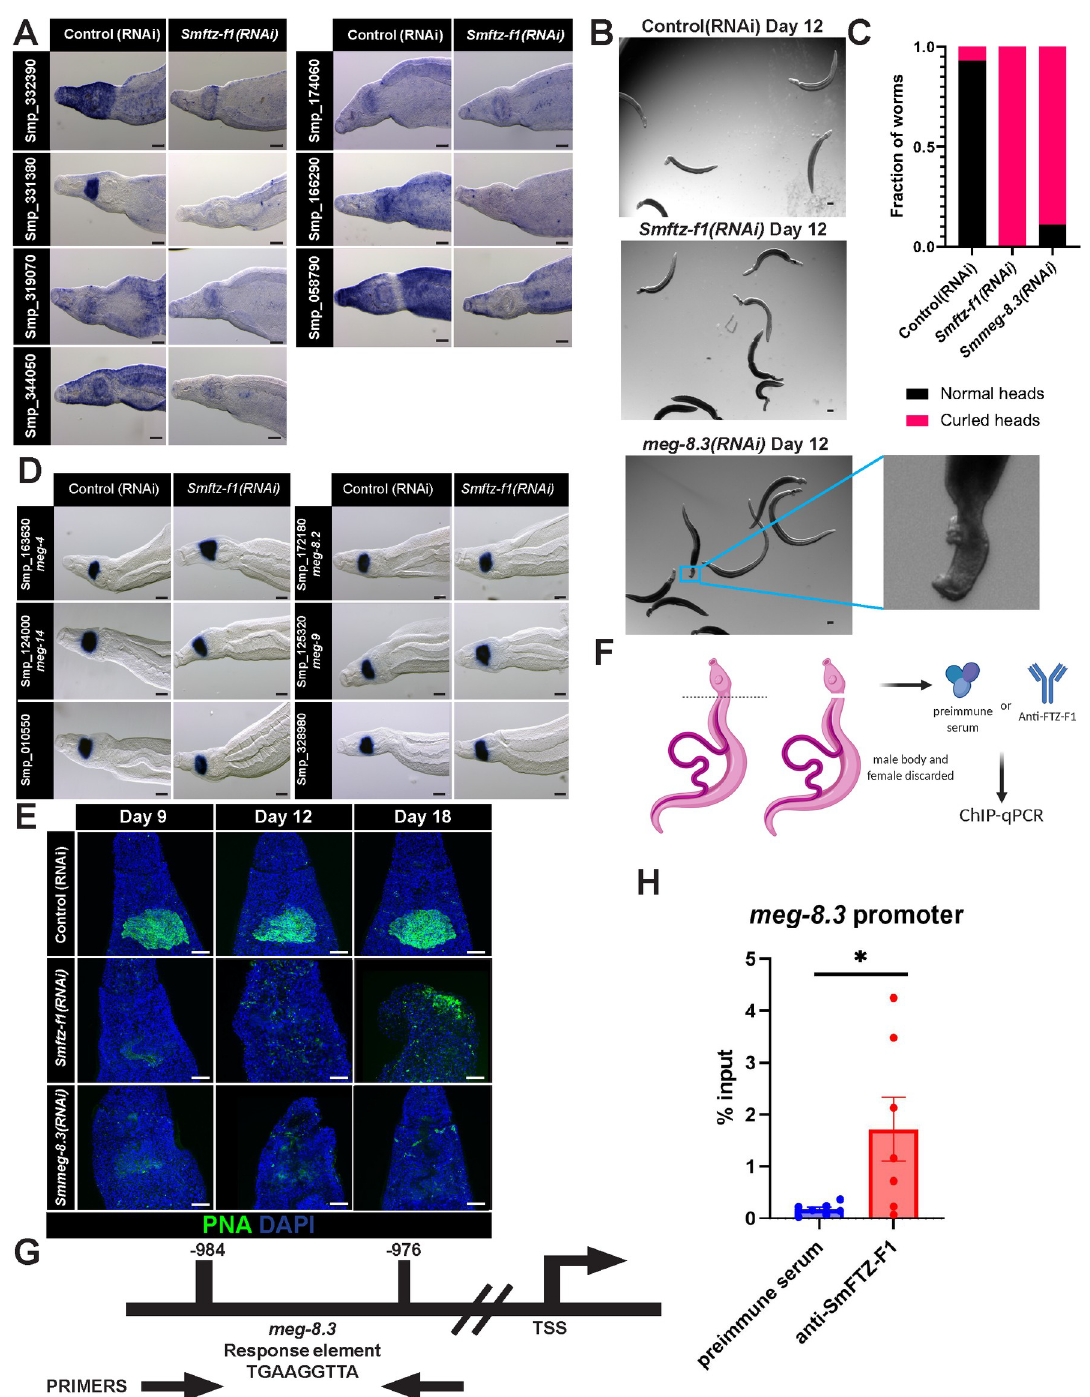
Fig 3. meg-8 . 3 is a putative target of SmFTZ-F1. (A) Whole mount in situ hybridizations for putative SmFTZ-F1 target genes on D9 of RNAi. Smp_331380 is exclusively expressed in the worm esophageal gland. n = 10 worms, 3 biological replicates. (B) Images of control, Smftz-f1 and meg-8 . 3 RNAi-treated worms during in vitro culture. Control(RNAi) animals remain firmly attached to the bottom of the plate, and move freely. At D12 of meg-8 . 3(RNAi) animals fail to attach to the bottom of the culture plate. Their heads begin to curl inward on themselves (see inset). n > 10 worms, 3 biological replicates. (C) Plots depicting the number of animals that display normal or curled phenotypes following RNAi treatment at D15. (D) Whole mount in situ hybridization of D9 Smftz-f1 RNAi- treated worms using known esophageal gland markers. Control and RNAi-treated worms show no difference in esophageal gland